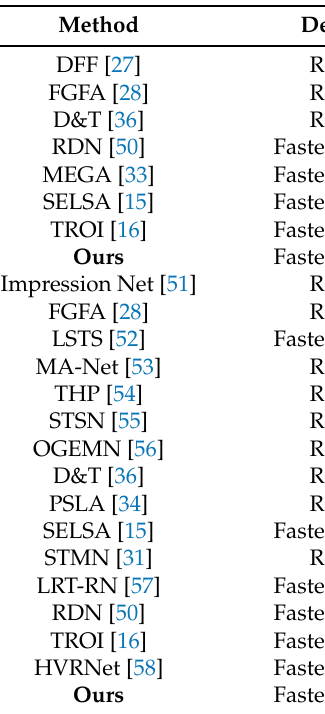
Table 6. Comparison of the proposed framework against recent state-of-the-art methods on the validation set of the ImageNet VID